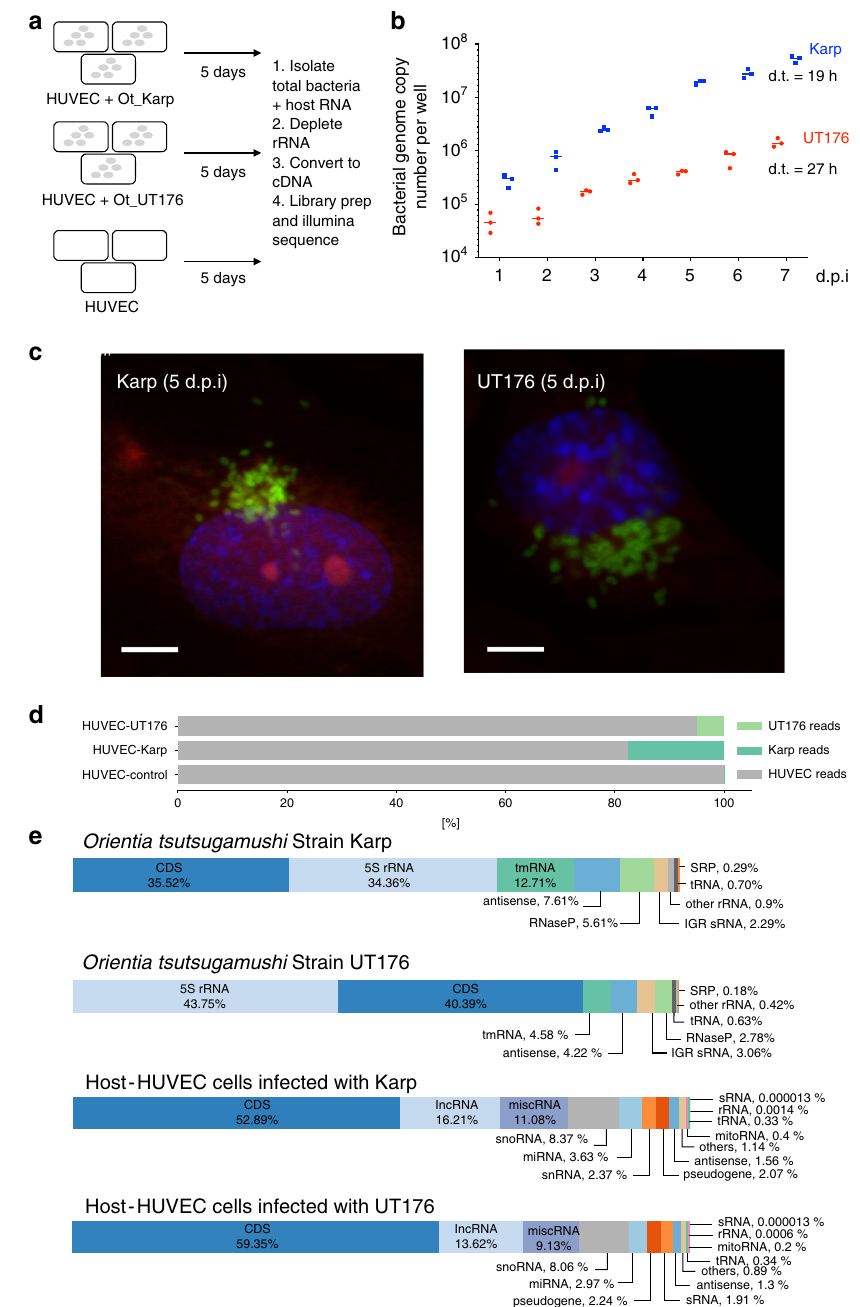
Fig. 1 Overview. a Schematic experimental overview. HUVEC = human umbilical vein endothelial cell. b Growth curve showing replication of Ot in cultured HUVEC cells. Bacteria were grown in 24-well plates and the total bacterial genome copy number per well as measured by qPCR is shown. Bacteria were added at an multiplicity of infection (MOI) of 8:1 (UT176) and 25:1 (Karp). Mean and SD from three independent replicates are shown. c Confocal microscopy images of Ot in HUVEC cells 5 days post infection. Additional images and time points are shown in Supplementary Figs. 1 and 2. Blue = DAPI (DNA), Red = Evans blue (host cells), green = Ot labeled with Alexa488-click-methionine. Scale bar = 5 µ m. d RNA mapping statistics showing the fraction of host and Ot RNA for each condition. The fi rst replicate of the experiment is shown. Individual results for each replicate are shown in Supplementary Fig. 3. e Percentage of RNA-seq reads assigned to different classes of RNA in Karp, UT176 and HUVEC. Source data are provided as a Source Data fi